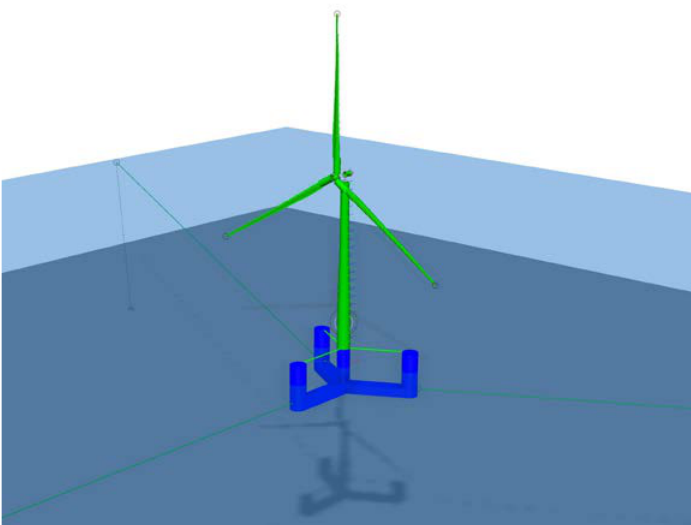
Figure 6. Comparison of the first-order wave excitation loads from WADAM and WAMIT.